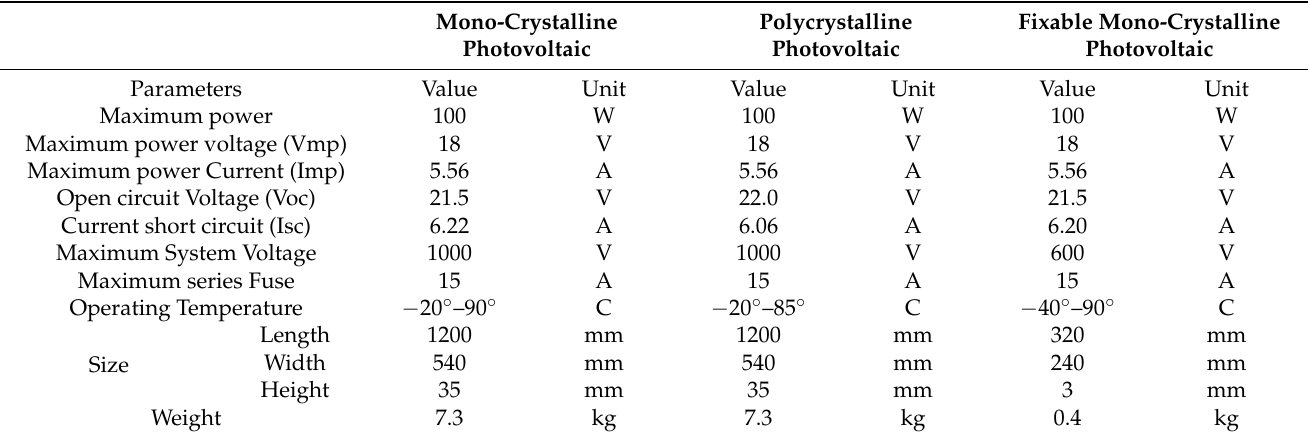
Table 2 illustrates the photovoltaic modules specifications. Table 2. PV module